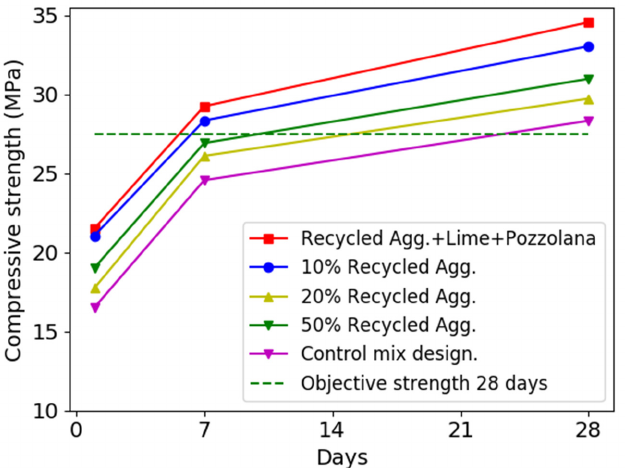
Figure 5. Compressive strength of different mixes at different curing ages.